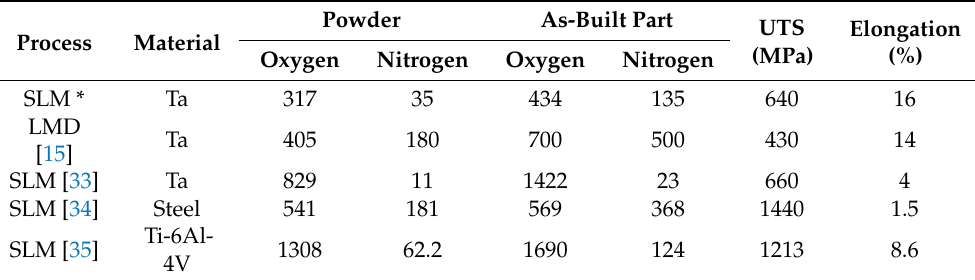
Table 5. The content of impurities and mechanical properties with different manufacturing techniques and metal powders. (Elemental content in ppm).